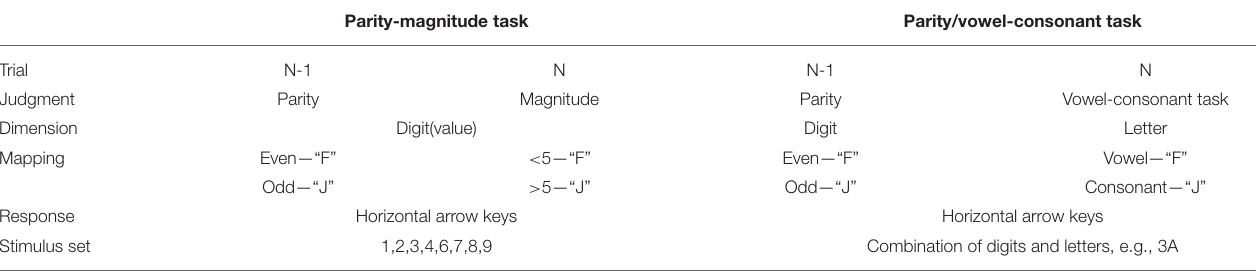
TABLE 1 | Features of parity-magnitude task and parity/vowel-consonant